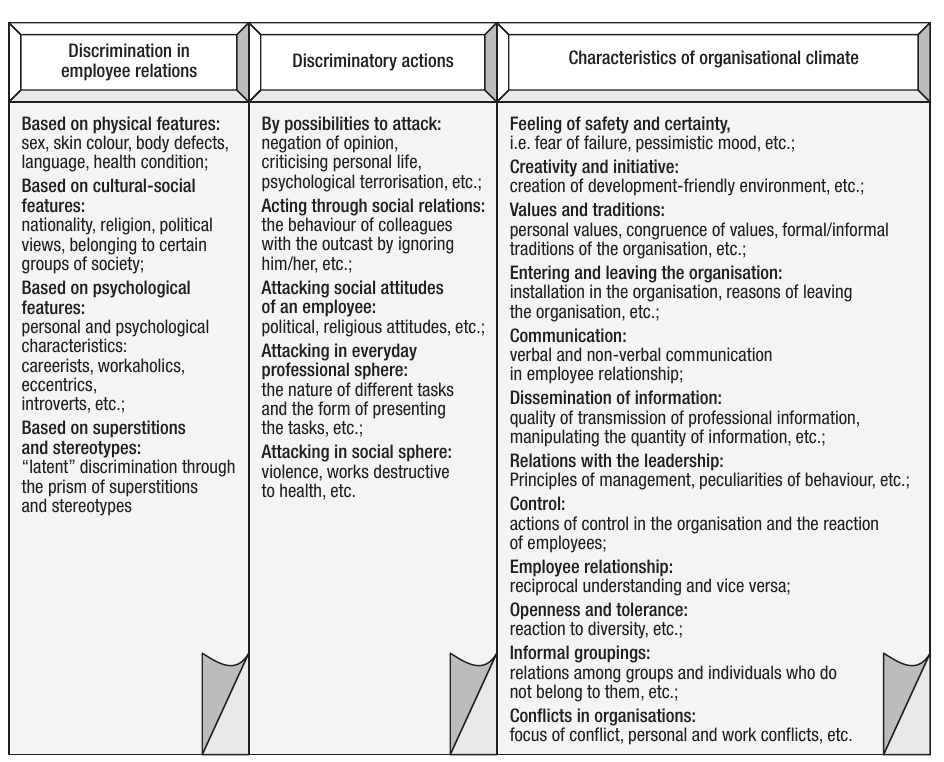
Fig. 1. Characteristics and criteria attributable to mobbing and organisational